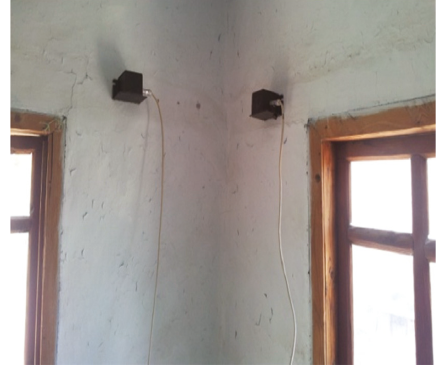
Figure 6: The sensor